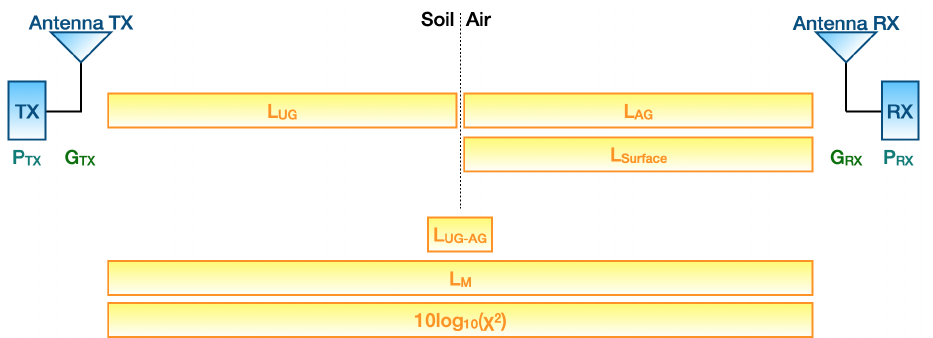
Figure 2. Block diagram of losses and gains occurring during a wireless UG2AG link according to Equation